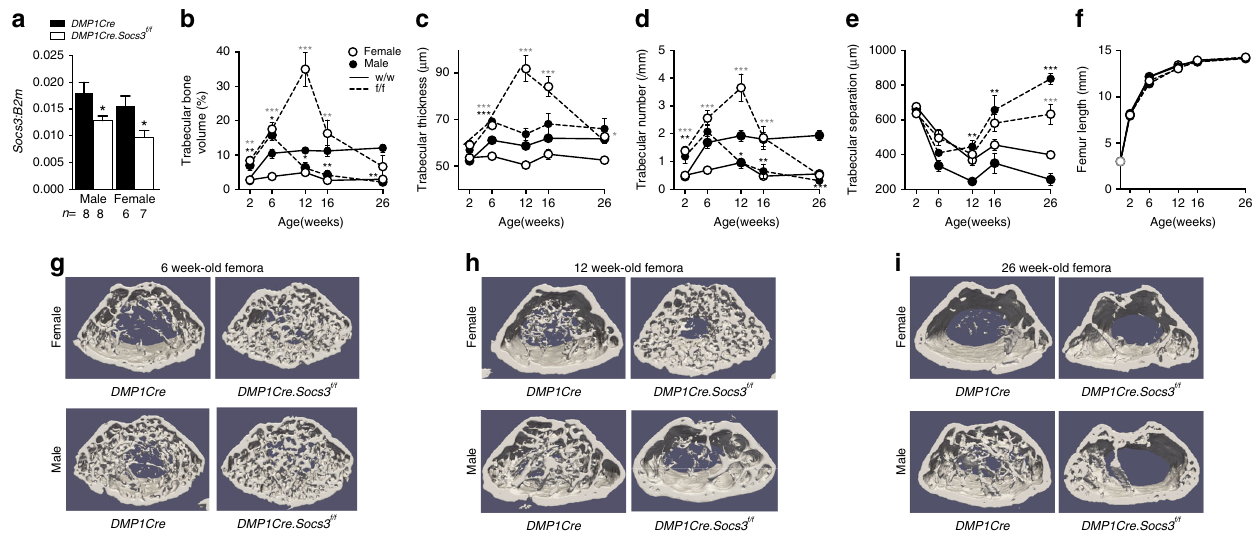
Fig. 1 Sex divergence in the adult bone phenotype in male and female Dmp1Cre.Socs3 f/f mice vs Dmp1Cre controls. a mRNA levels of Socs3 in femora, fl ushed of marrow, from 12-week-old Dmp1Cre.Socs3 f/f and Dmp1Cre littermates; values are mean + SEM, n shown below graph, * p < 0.05 vs Dmp1Cre by two-way ANOVA with Sidak post-hoc test. Femoral trabecular bone volume ( b ), trabecular thickness ( c ), trabecular number ( d ), trabecular separation ( e ), and femoral length ( f ) of 2, 6, 12, 16, and 26-week-old male ( fi lled circles ) and female ( open circles ) Dmp1Cre.Socs3 f/f ( dashed lines — f/f) and Dmp1Cre ( solid lines — w/w) mice. Values are mean ± SEM; numbers are as follows in the order female w/w, female f/f, male w/w, male f/f: 2 weeks (7, 8, 8, 7); 6 weeks (9, 11, 12, 10); 12 weeks (11, 10, 10, 9); 16 weeks (9, 8, 11, 7); 26 weeks (9, 9, 9, 10). * p < 0.05; ** p < 0.01; *** p < 0.001; vs Dmp1Cre of the same age and sex by two-way ANOVA with Sidak post-hoc test; gray stars indicate signi fi cant differences in females. Representative thresholded micro-CT images of the metaphyseal region used for analysis in 6-week-old ( f ), 12-week-old ( g ), and 26-week-old ( h ) mice showing time-dependent and sex-dependent modi fi cations in trabecular structure. Images are not to